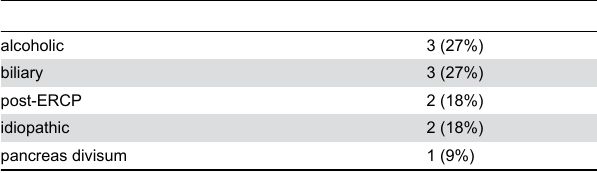
Table 2. Etiology of acute pancreatitis